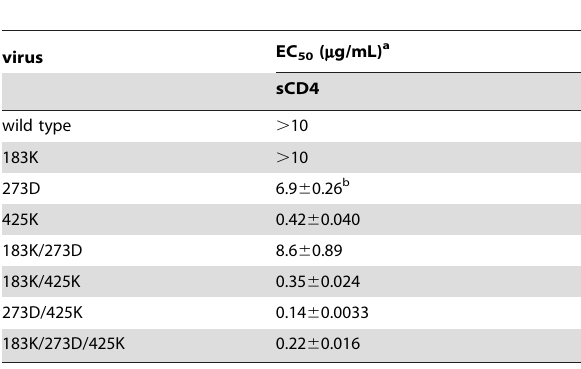
Table 3. Susceptibility of recombinant pseudotyped viruses to sCD4 determined by single-round entry